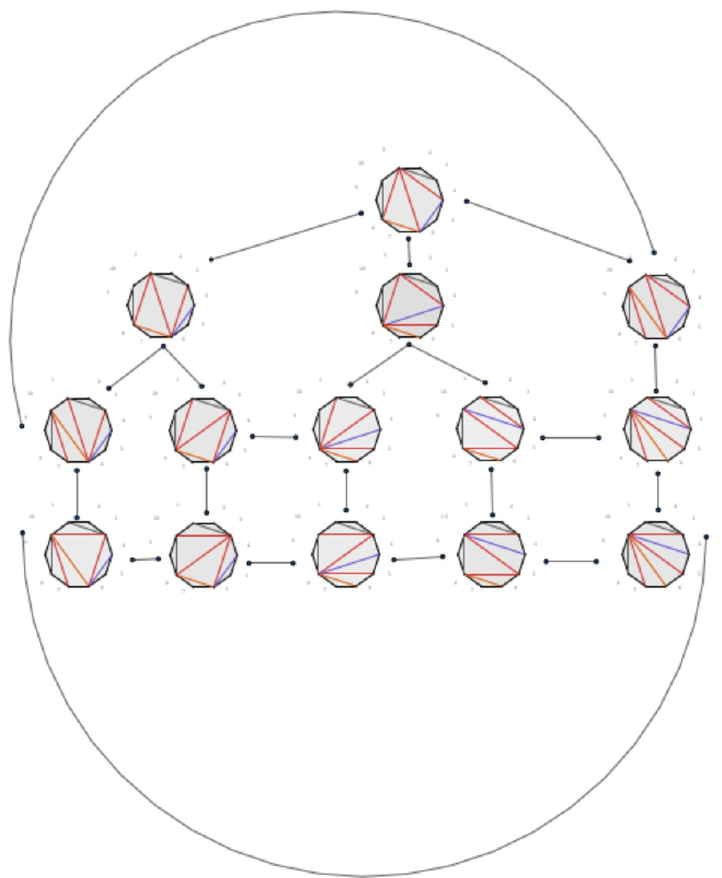
Figure 18 . In the Snake case the corresponding Stokes polytope is an associahedron A